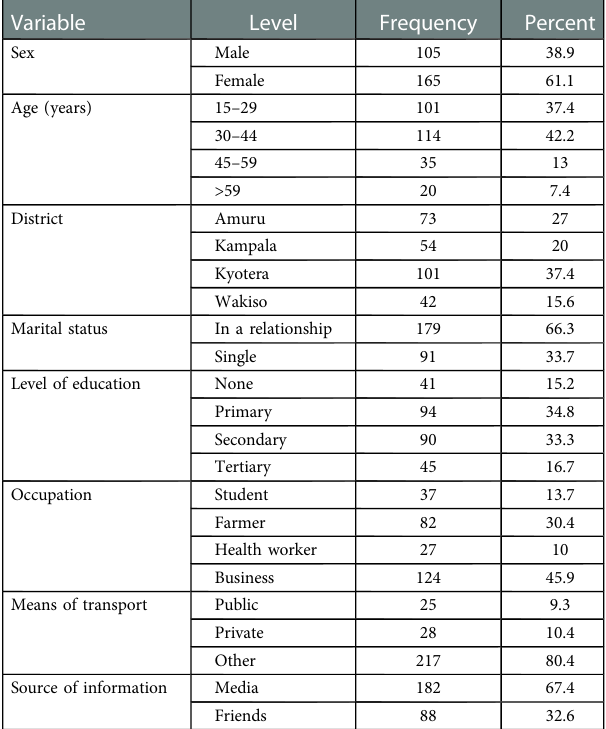
TABLE 1 Demographic characteristics of the